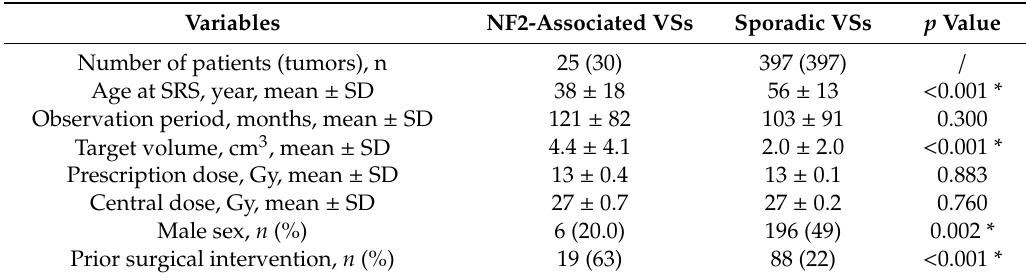
Table 1. Baseline characteristics and dosimetry data of patients before matching. * Values of p < 0.05 are considered statistically significant. NF2 = neurofibromatosis type 2; VS = vestibular schwannoma; SRS = stereotactic radiosurgery; SD = standard deviation; Gy =